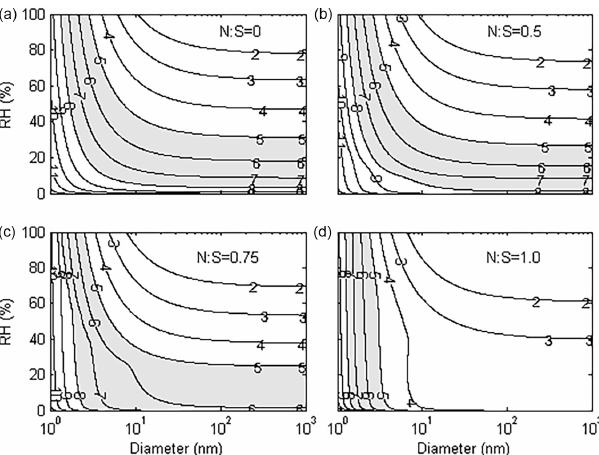
Figure 6. Modelled effective H 2 SO 4 saturation concentration, (cid:16) (cid:17) C ∗ C ∗ (moleculescm − 3 ) , expressed in log 10 , at H 2 SO 4 , S H 2 SO 4 , S T = 288.8K, RH 0–100% and particle diameters in the range from 1 to 10 3 nm. The contours represent H 2 SO 4 gas-phase concen- (cid:16) (cid:17) = 7 corresponds to C ∗ = C ∗ trations, e.g. log 10 H 2 SO 4 , S H 2 SO 4 , S 10 7 moleculescm − 3 . The grey shading indicates the atmospheric range of H 2 SO 4 (10 5 − 10 8 cm − 3 ) . The results correspond to particles composed (a) only of S(VI) and H 2 O (N:S = 0), (b) with N:S = 0.5, (c) with N:S = 0.75 and (d) with N:S = 1. = 2.40 × 10 9 molkg − 1 and The equilibrium constants are K H 2 SO 4 x K = 1.43 × 10 10 . The pure-liquid saturation vapour pressures SO 3 of H 2 SO 4 and SO 3 are calculated with Eqs. (11) and